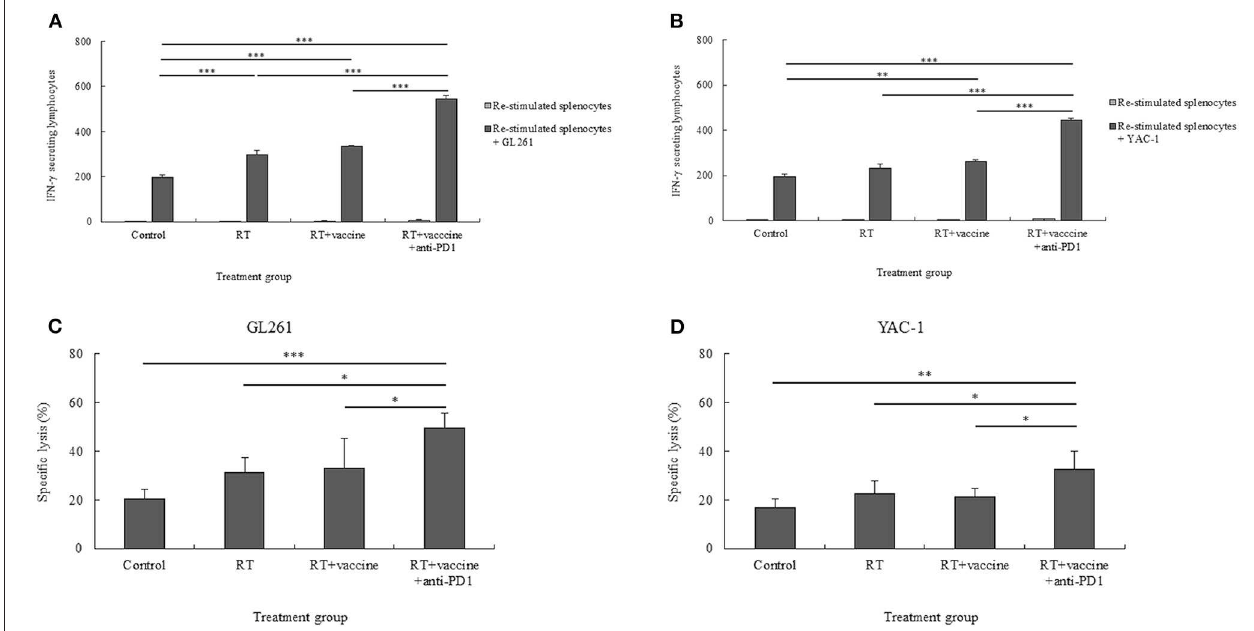
FIGURE 6 | The cytotoxic T lymphocyte (CTL)- and natural killer (NK) cell-mediated immune response of re-stimulated splenocytes from vaccinated mice. The IFN- γ secreted by re-stimulated splenocytes when co-cultured with target cancer cells was measured using the IFN- γ ELISPOT assay (A,B) . The specific killing effects of re-stimulated splenocytes against target cancer cells was confirmed using the LDH assay (C,D) . The GL261 and YAC-1 cell lines were used as target cells for CTL and NK cell sensitivity, respectively. All data are represented as the mean of two independent experiments. GL261, mouse glioblastoma cell line; YAC-1, mouse lymphoma cell lines sensitive to the cytotoxic activity of naturally occurring killer cells in mice; Control, no treatment group; RT, radiation therapy; vaccine, branched multipeptide plus PADRE and poly-ICLC; * p < 0.05; ** p < 0.01; and *** p <